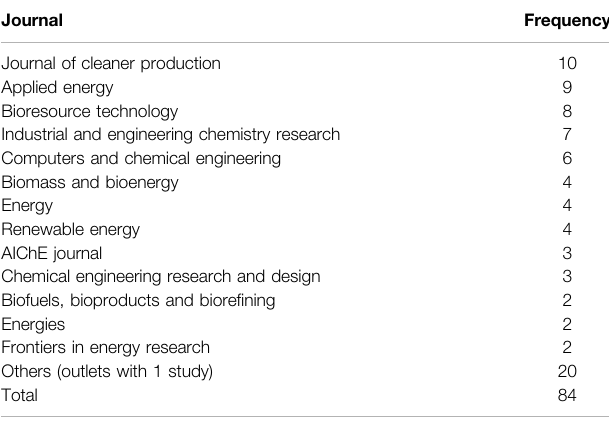
TABLE 1 | Journals in which the articles of the fi nal review database were published.